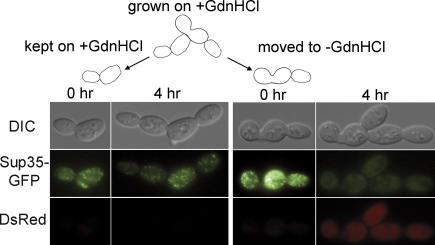
Sup35-GFP[PSI+] Complexes, Which Persist after Hsp104 Inhibition, Remain Substrates for This Disaggregase upon Its ReactivationWild-type zygotes (SY876 × 74D-694) constitutively expressing SUP35 and GST(UGA)DsRED with existing Sup35-GFP (previously expressed from PMFA1) were isolated in the presence of GdnHCl and allowed to form microcolonies. As indicated in the schematic diagram, a portion of this colony was retained on medium containing GdnHCl (0 h, left), and the remainder of the colony was transferred to medium lacking GdnHCl (0 h, right). The cells were imaged again 4 h after the transfer. Representative DIC, GFP, and DsRed images are shown (n = 9).